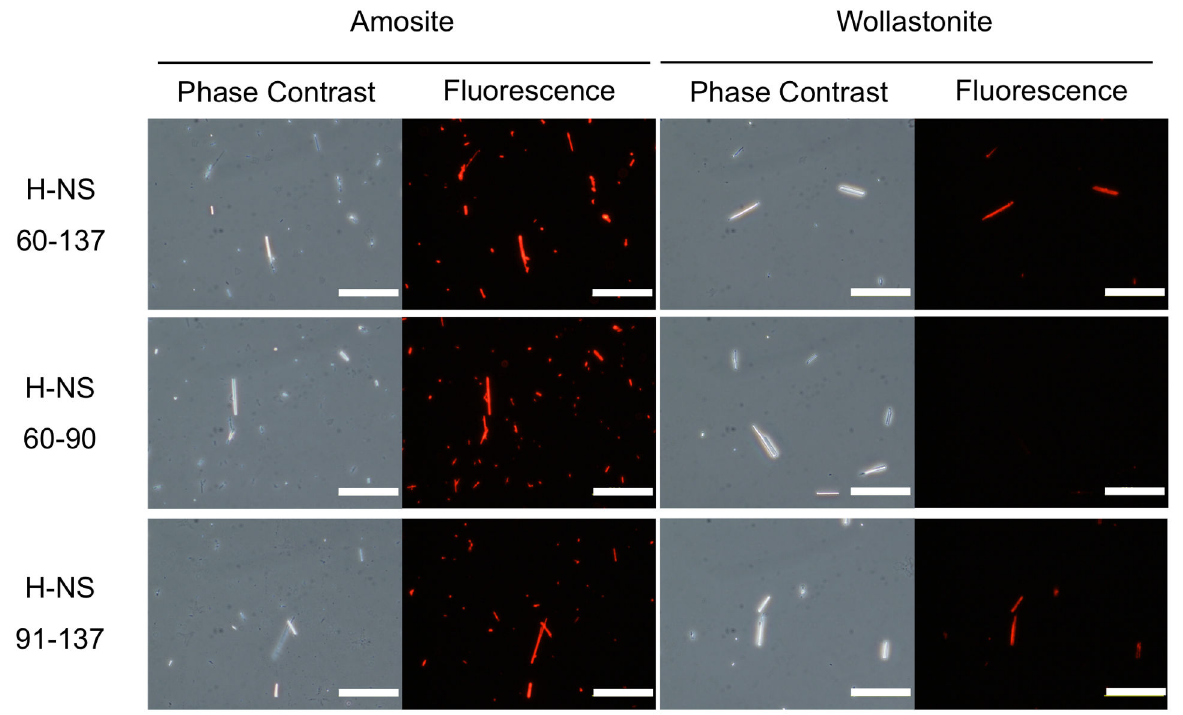
Figure 2. Specificity of fluorescently labeled tetramers of H-NS fragments. The fibers are stained with fluorescently labeled tetramers of the indicated H-NS fragments. Each pair of phase contrast and fluorescence micrographs of amosite and wollastonite fibers shows the same field of view. Bar, 50